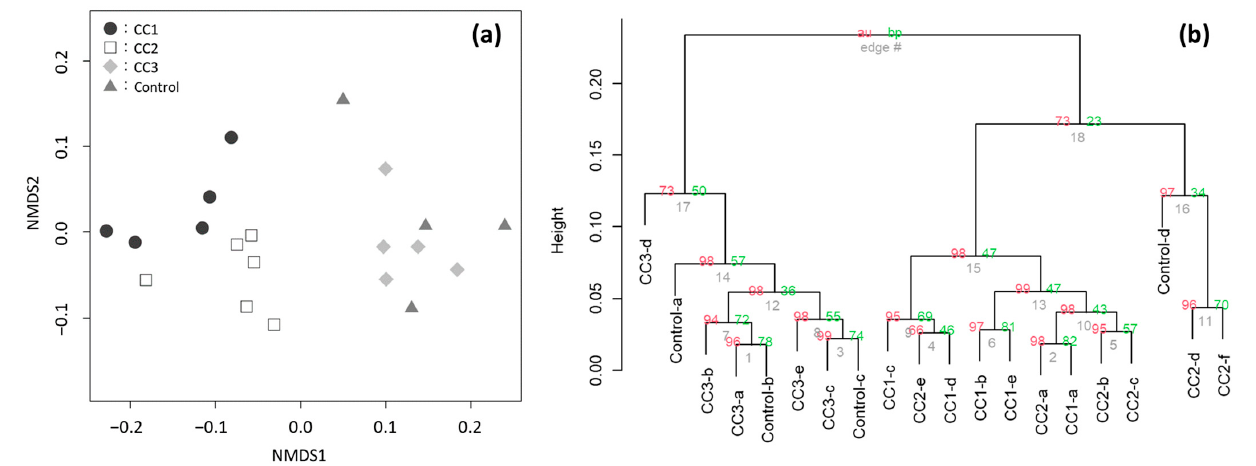
Figure 2. ( a ) The non-metric multidimensional scaling (NMDS) analyses of the soil bacterial community compositions in clear-cutting plots (CC1, CC2, and CC3) and the Control plot. ( b ) The hierarchical clustering according to the group average method. Near nodes au and bp p -values, the number of replications based on the bootstrap is 1000. A sample with 4000 leads or more was used for the both analyses.